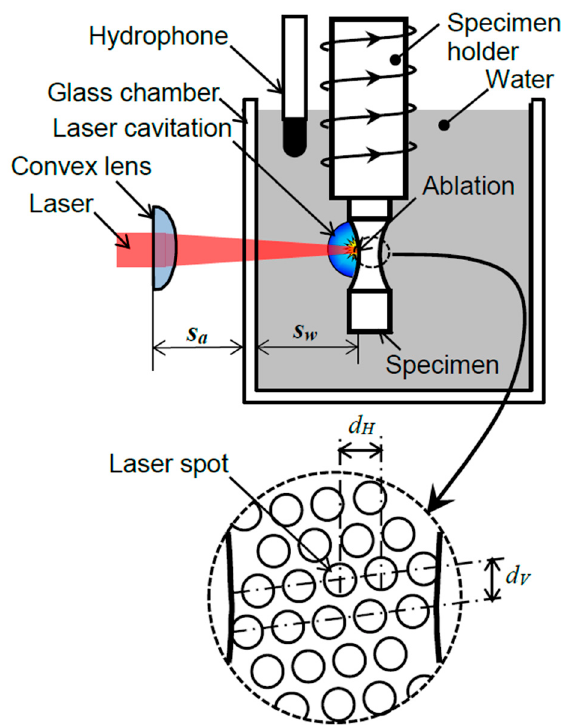
Figure 2. Schematic diagram of mechanical surface treatment using laser cavitation.